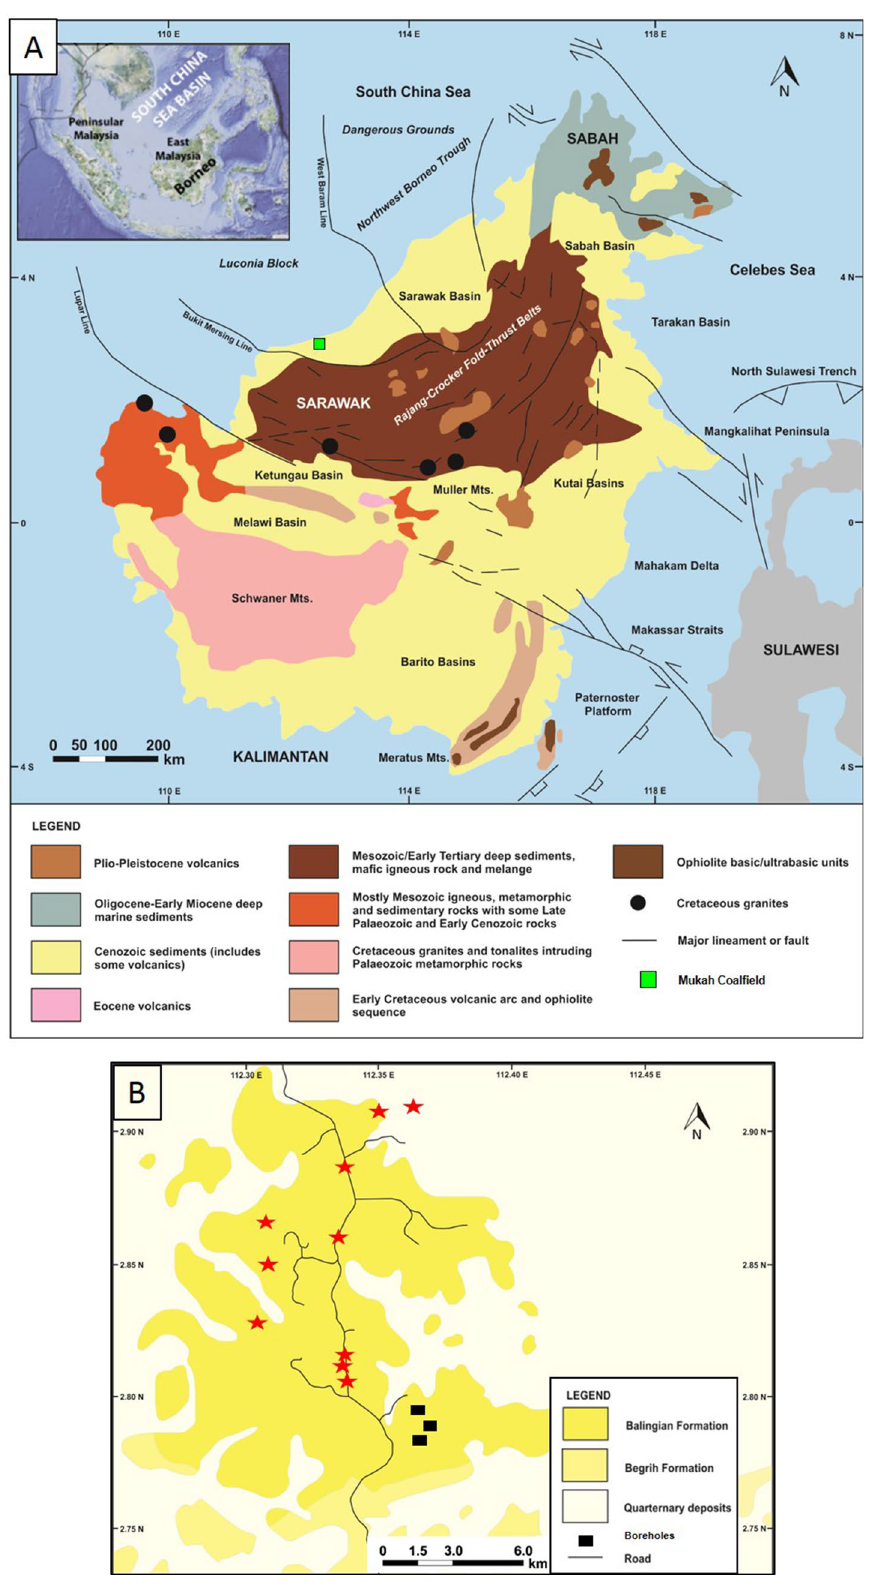
Figure 1. ( A ) Geological map of Borneo (modified from Widodo et al. 3 ). ( B ) Location map of the Mukah coalfield and borehole location of this study. Note the red star symbols represent the sampling locations taken by Sia and Abdullah 6 , Sia et al. 1 , Hakimi et al. 9 , and Murtaza et al. 8